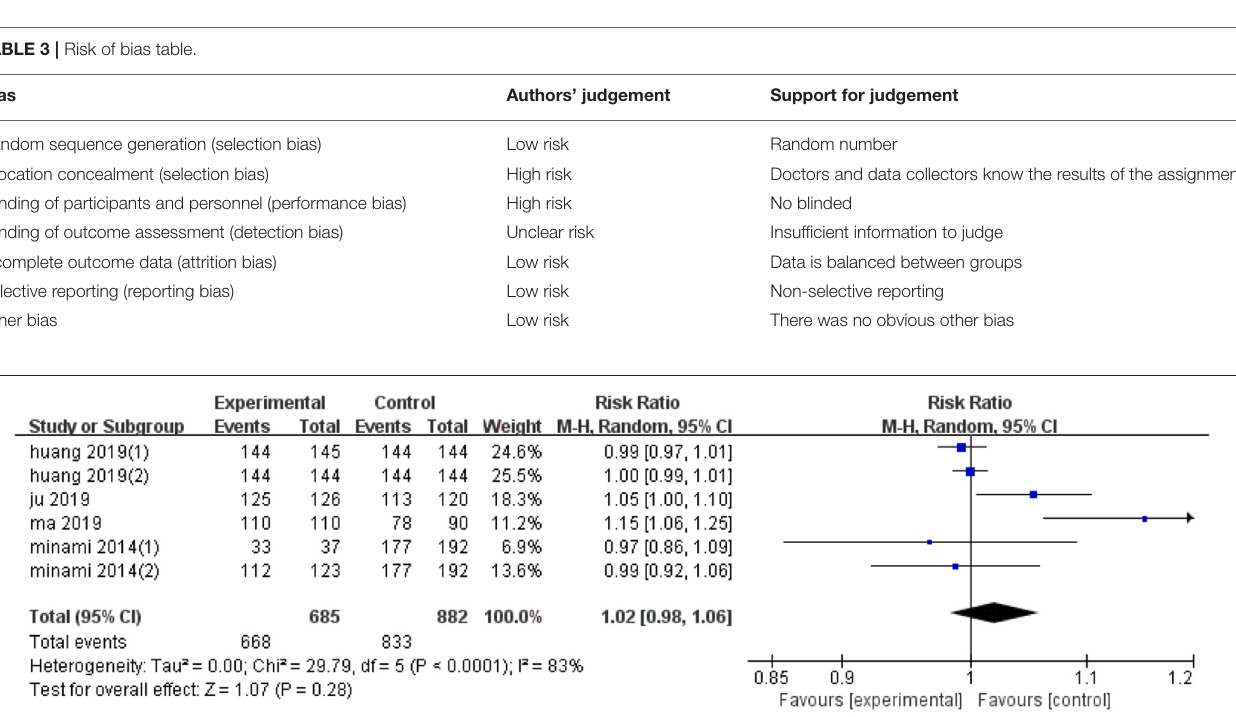
A single asterisk ( * ) indicates 1 score, and dash (–) indicates 0 score.